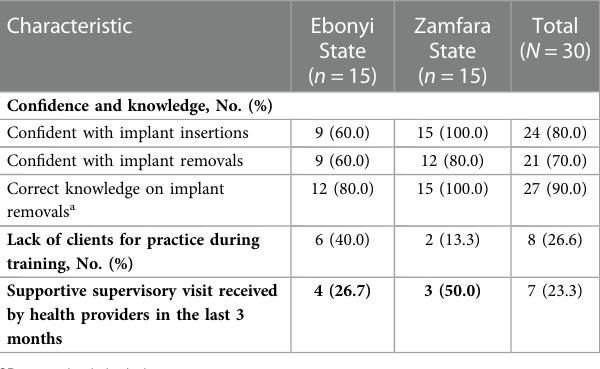
TABLE 2 Health provider characteristics related to implant insertions and removals in Ebonyi and Zamfara States, Nigeria.